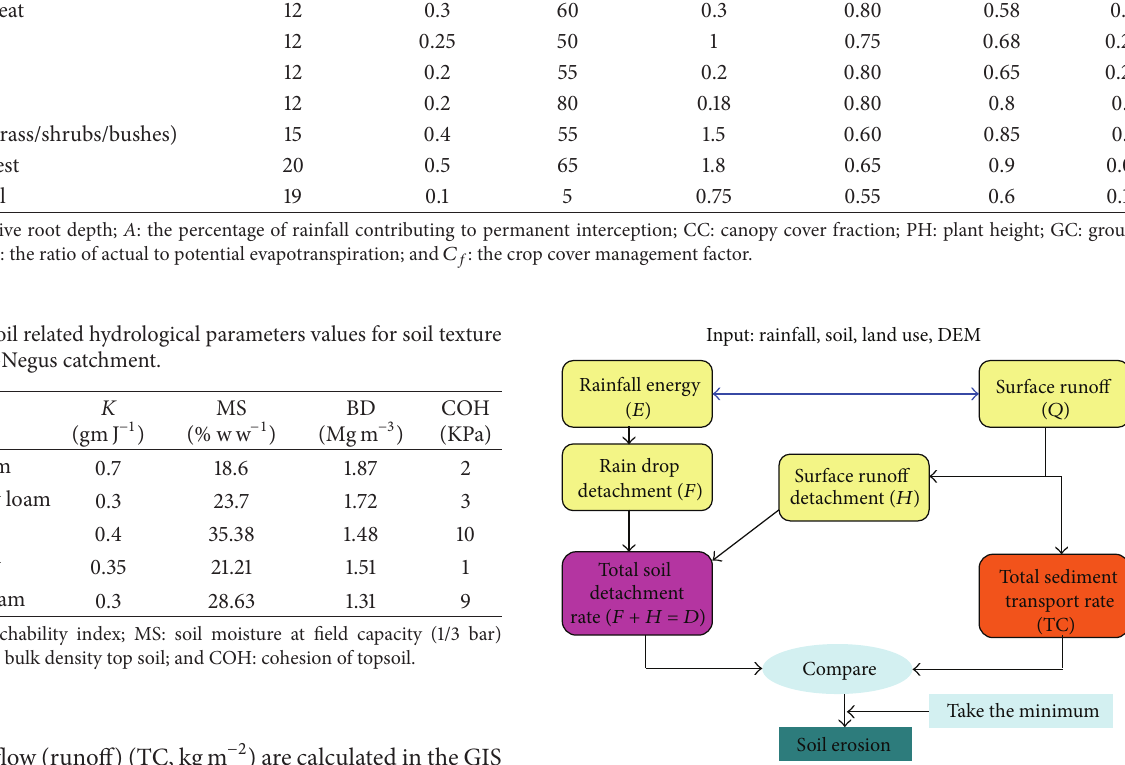
Figure 4: Flow chart depicting the methodology used for MMF modelling (source: Morgan et al.